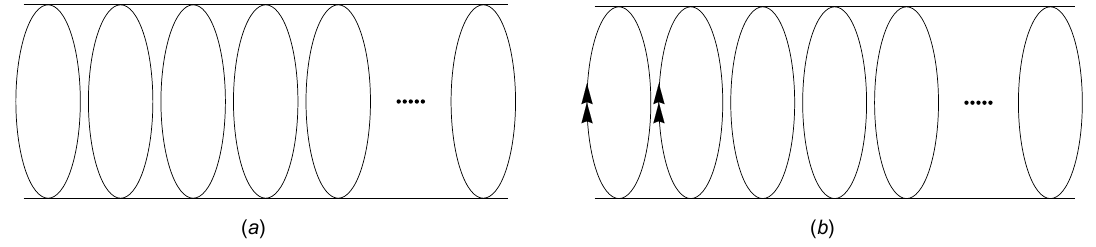
Figure 1 . (a) N singly-wound component strings in their vacuum state wrapping the S 1 ; this